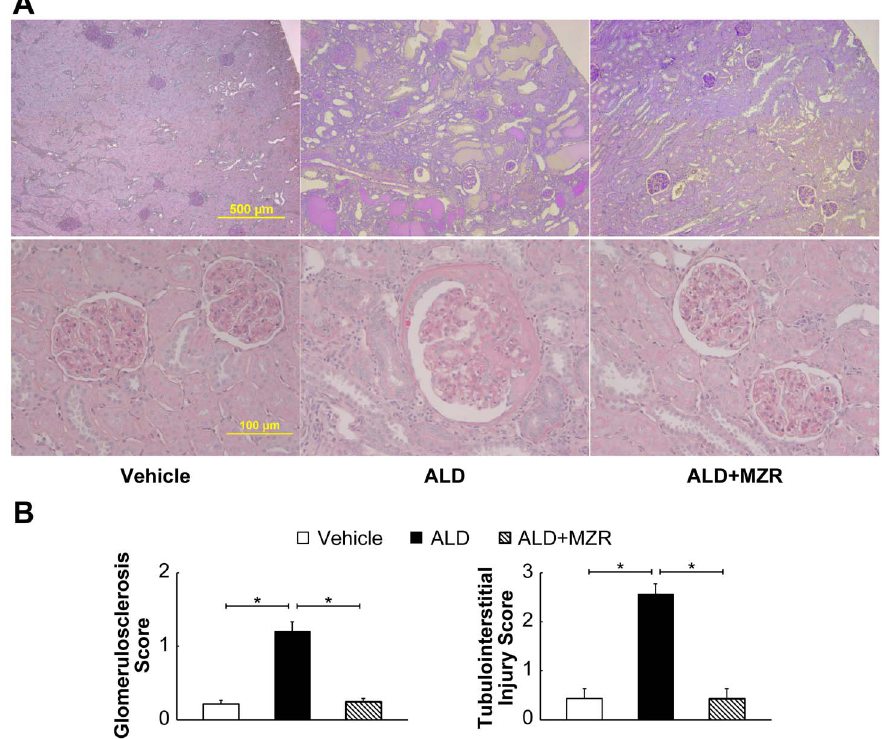
Figure 6. Mizoribine attenuates histological aldosterone-induced renal damage. Aldosterone (ALD) induced severe glomerular and tubulointerstitial injury, whereas mizoribine (MZR) markedly attenuated the injury. (A) Representative photomicrographs of glomeruli and tubulointerstitial areas with periodic acid-Schiff staining. (B) Graphs show the quantification of glomeruli and tubulointerstitial injury. Values are presented as mean 6 SEM. * P ,